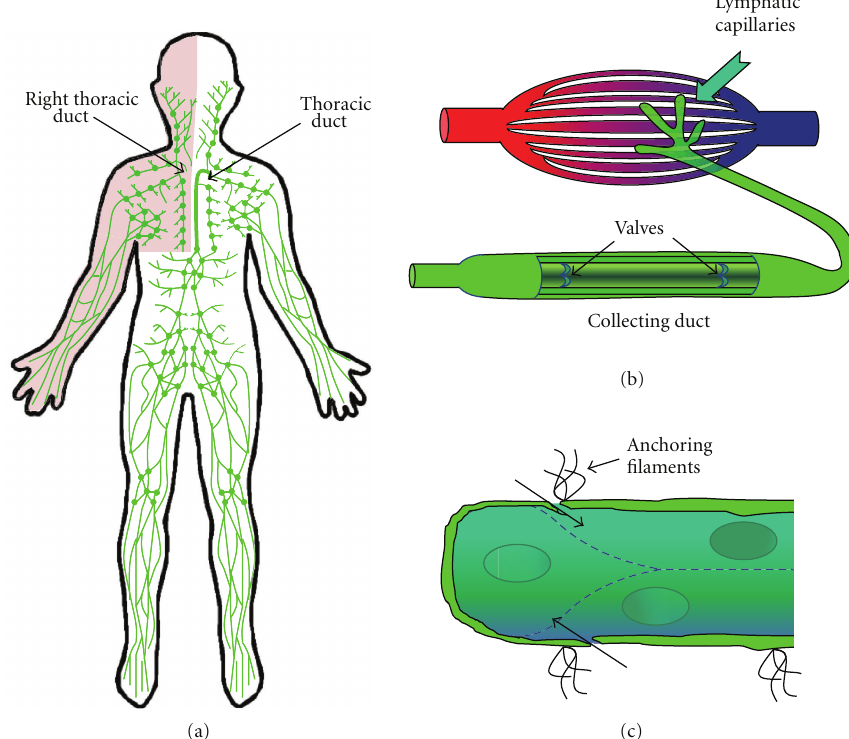
Figure 1: Lymphatic system structure. (a) The lymphatic system is separated into two distinct sets of tubules. Lymphatic vessels drain various areas of the body passing the material through a series of lymph nodes before returning the material to the venous circulation through the thoracic ducts. (b) Lymphatic capillaries drain interstitial fluid that accumulates during capillary exchange. The protein and cell-rich fluid termed lymph is then transported into vein-like valved collecting tubules. (c) Anchoring filaments couple lymphatic capillary endothelial cells to the surrounding matrix. Forces applied through these anchoring filaments enhance lymphatic permeability to promote tissue drainage.